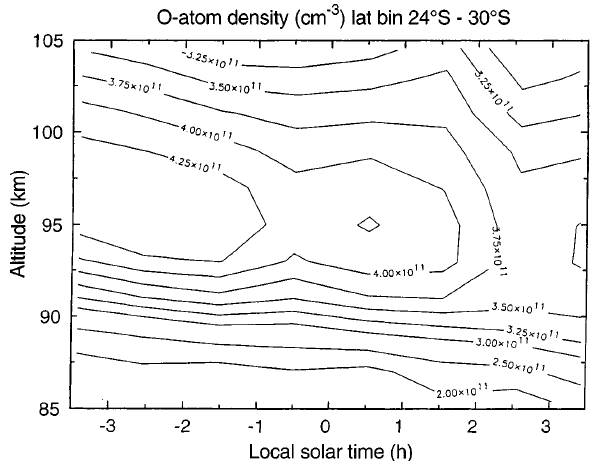
Fig. 2. The 553 nm nightglow continuum volume emission rates measured by WINDII for the same local solar time/latitude bin as Fig. 1